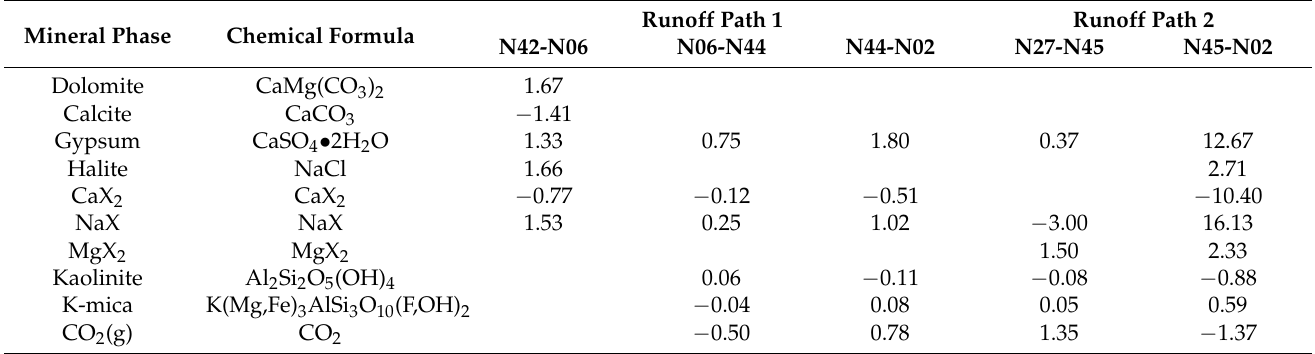
Table 1. Inverse geochemical modeling of groundwater path simulation results (unit: